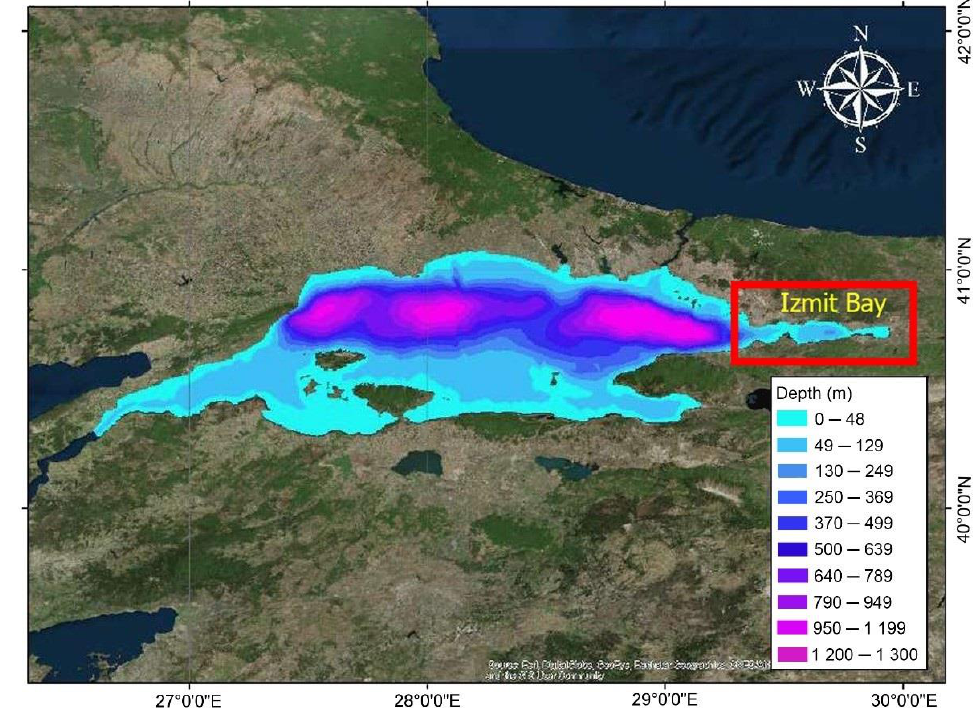
Figure 2. Bathymetry of Marmara Sea [33].